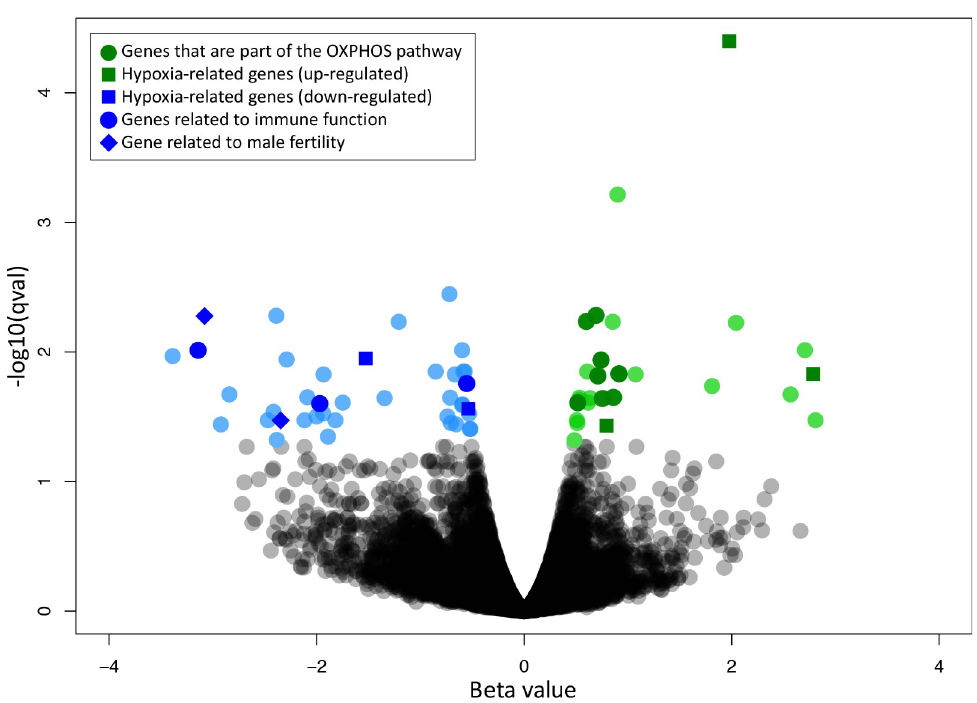
Fig 2. Volcano plot of differential expression between the 5,000 m site and the two lower-elevation sites. Each point is a transcript. The x-axis is the beta value which is the natural log of the fold difference and the y-axis is the–log 10 (qval). The q-value is the multiple test corrected p-value. Colored points are significantly differentially expressed between the high- elevation group and the other locations at a q-value of < 0.05. Transcripts falling above zero on the x-axis (green) are upregulated in the 5,000 m samples and transcripts falling below zero (blue) are down-regulated. Transcripts driving the enrichment of the OXPHOS pathway are shown in dark green circles. Transcripts identified in the text to be of particular interest based on our literature search are also shown with a dark green or dark blue point, with different shapes indicating what each gene is related to.